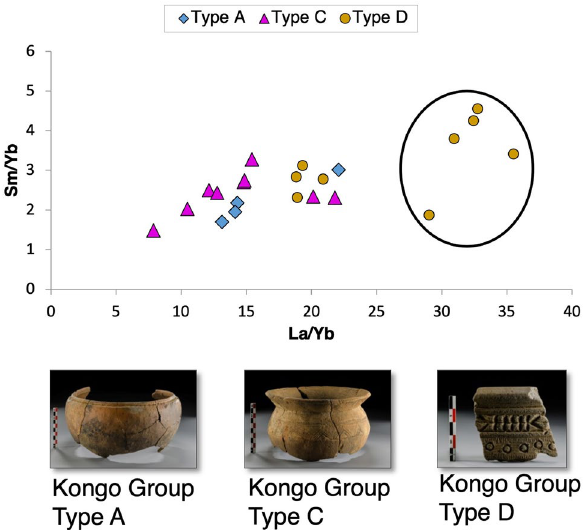
Figure 8. ICP-MS data. Scatter plot of La/Yb-Sm/Yb, selected samples from Kongo kingdom pots, color coded by typological group. The Kongo Type C sample MBK_S.14 is not depicted on the